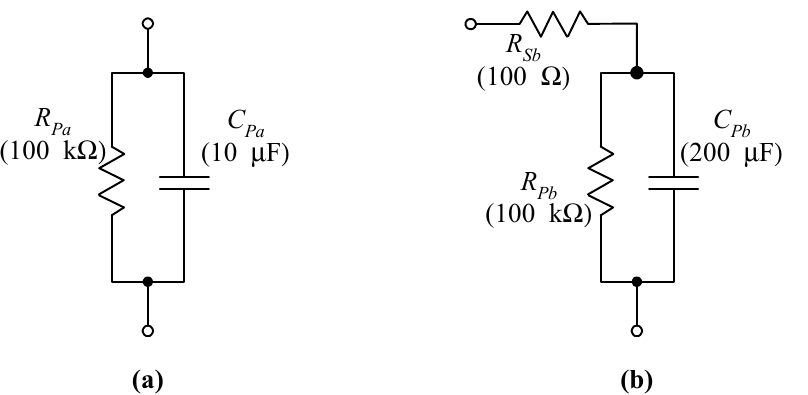
Figure 6. Impedances used for testing the proposed approach. Capacitor C Pa in ( a ) is a 10 μ F, 100 V polyester capacitor; capacitor C Pb in ( b ) is obtained as the parallel of 20 10 µ F, 100 V polyester capacitors.